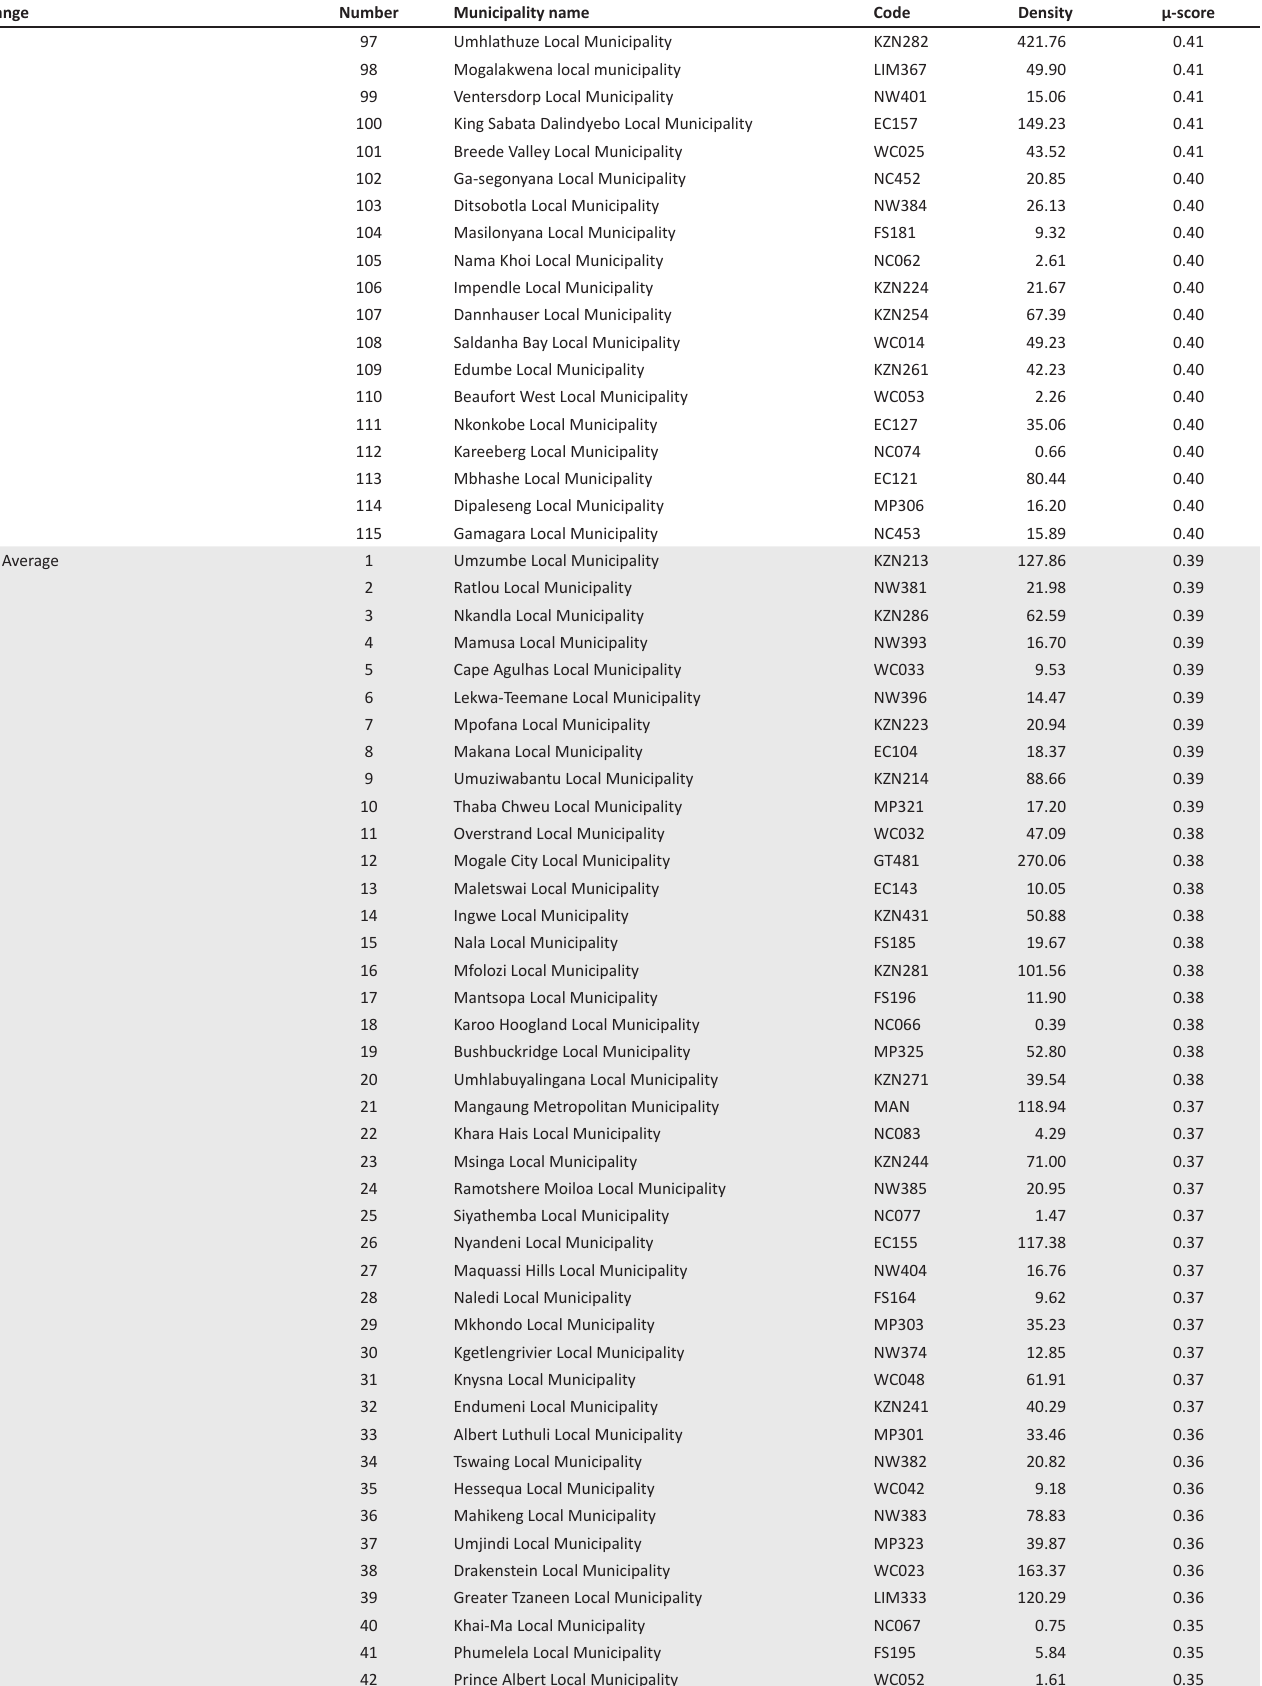
TABLE 1-A1 (Continues...): Financial condition scores by rank.